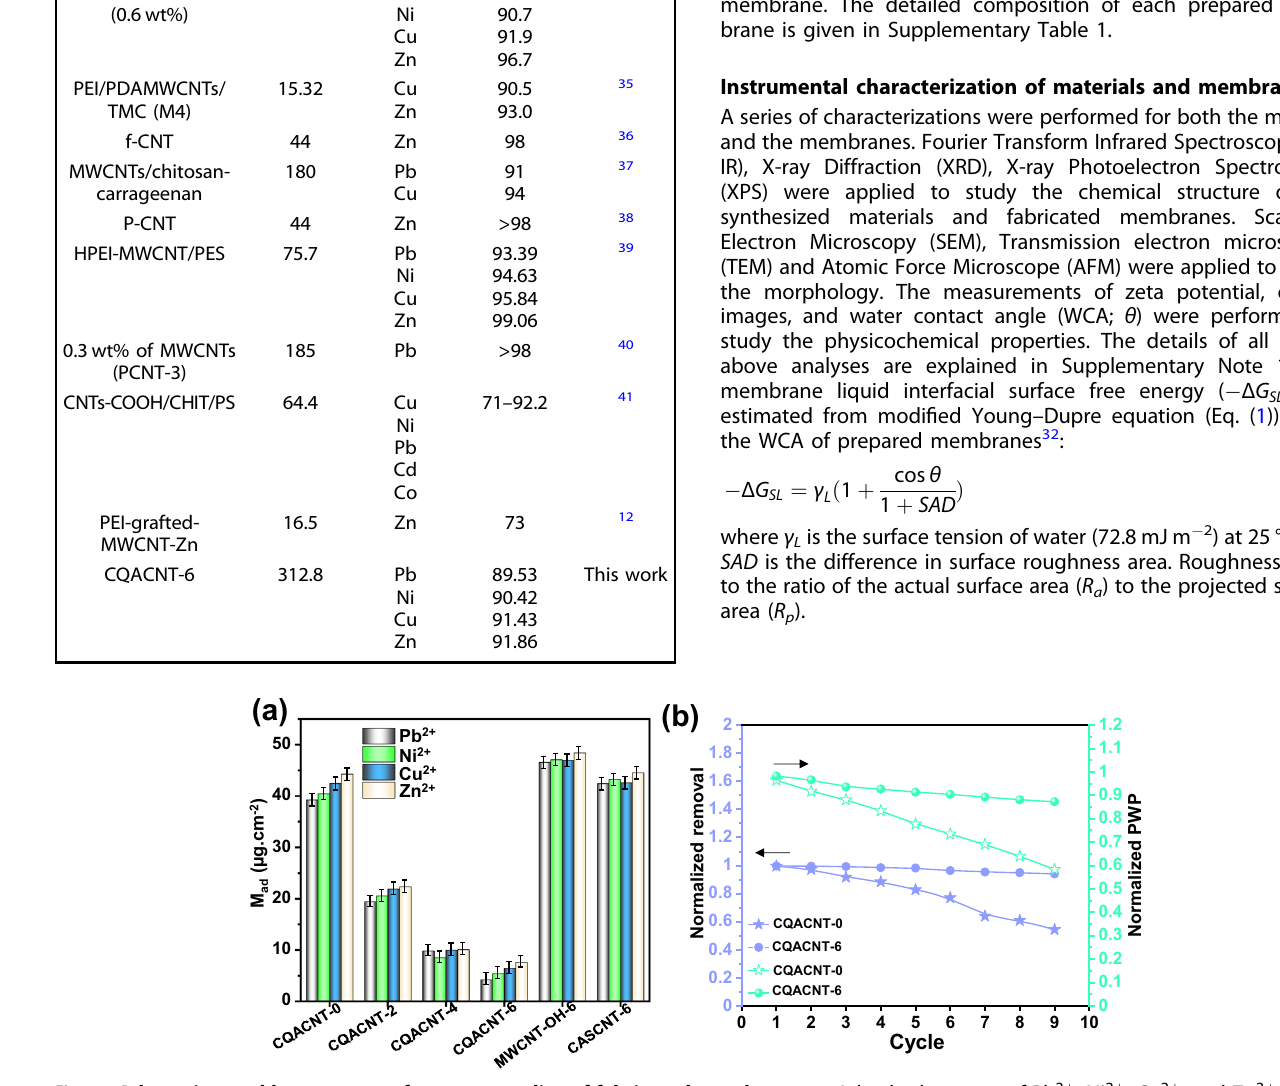
Fig. 9 Adsorption and long-term performance studies of fabricated membranes. a Adsorbed amount of Pb 2 + , Ni 2 + , Cu 2 + , and Zn 2 + by the developed composite membranes CQACNT, MWCNT-OH-6 and CASCNT-6; b Normalized PWP and normalized removal of CQACNT-0 and CQACNT-6 membranes. Error bars represent the standard deviation between three reported values.